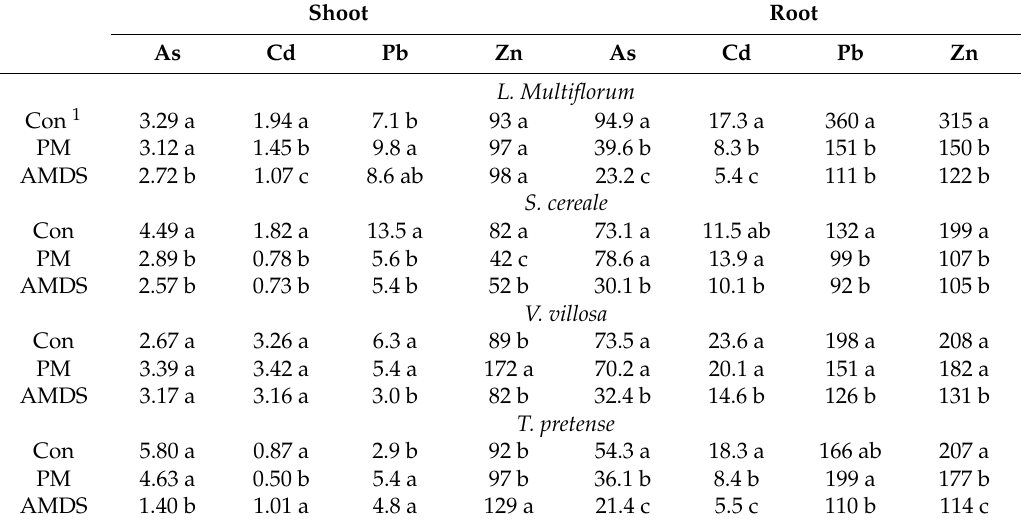
Table 3. Heavy metals and metalloids (As, Cd, Pb, and Zn) concentrations (mg kg − 1 ) in plants shoot and root of cultivated plants ( Loliummultiflorum and Secalecereale (Poaceae family representatives) and Trifoliumpratense and Viciavillosa (Leguminosaefamily representatives)) based on dry weights ( n =